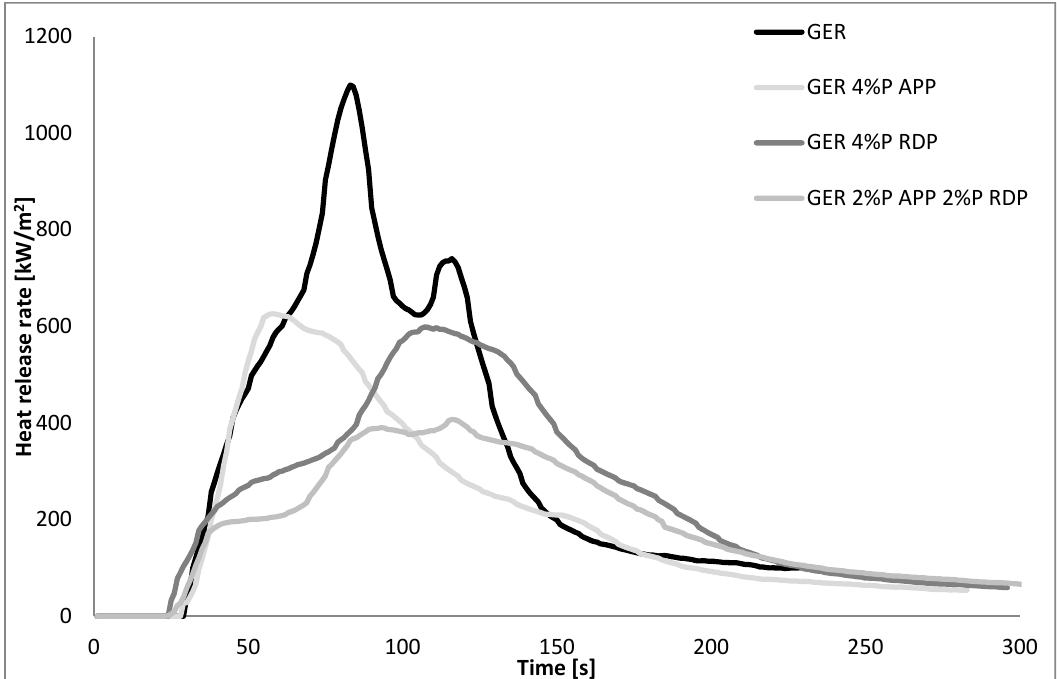
Figure 2. The heat release rate of the reference and flame retarded GER matrices.